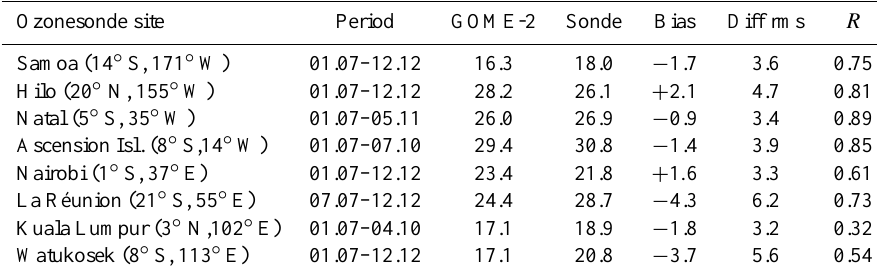
Table 1. Statistical comparison between GOME-2 and ozonesonde TOCs based on monthly ensemble averages for eight SHADOZ sites. Included for each site are the measurement period, the mean TOC from GOME-2 and the ozonesondes, the bias and rms difference between the two, and the correlation coefficient R . The ozone column values are in